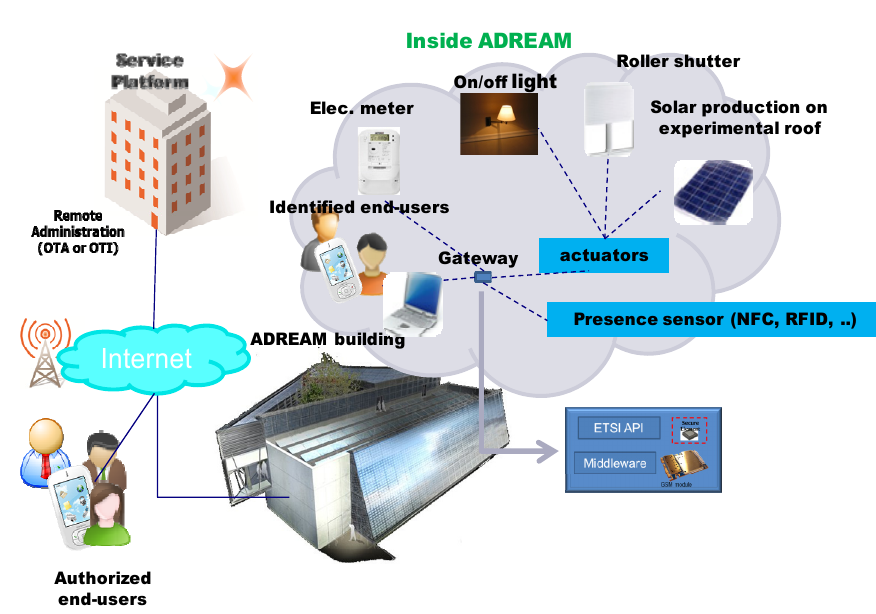
Figure 18. Smart metering